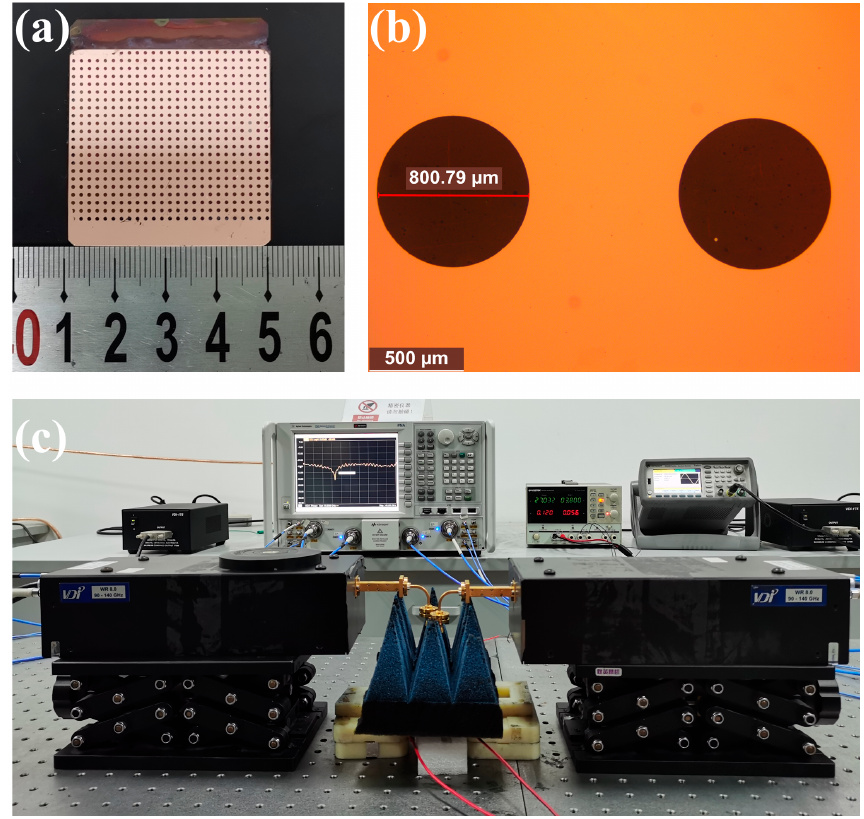
Figure 2. ( a ) The sample structure (4 × 4 cm 2 ). ( b ) The unit cells of the periodic pattern under a metallographic microscope. ( c ) Sample testing apparatus.